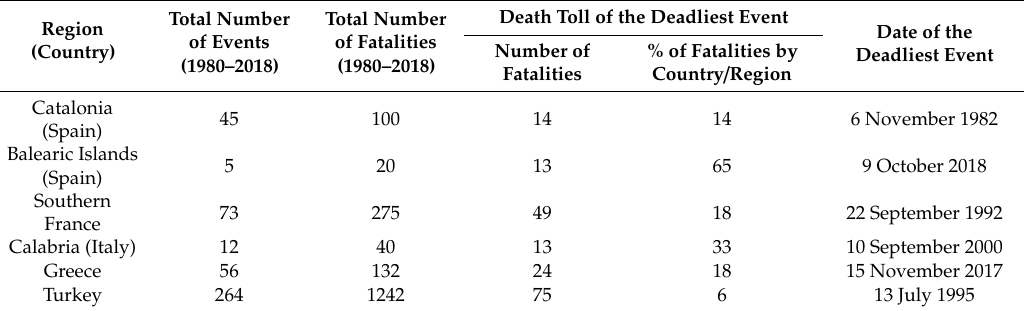
Table 6. Weight of the deadliest event for each case